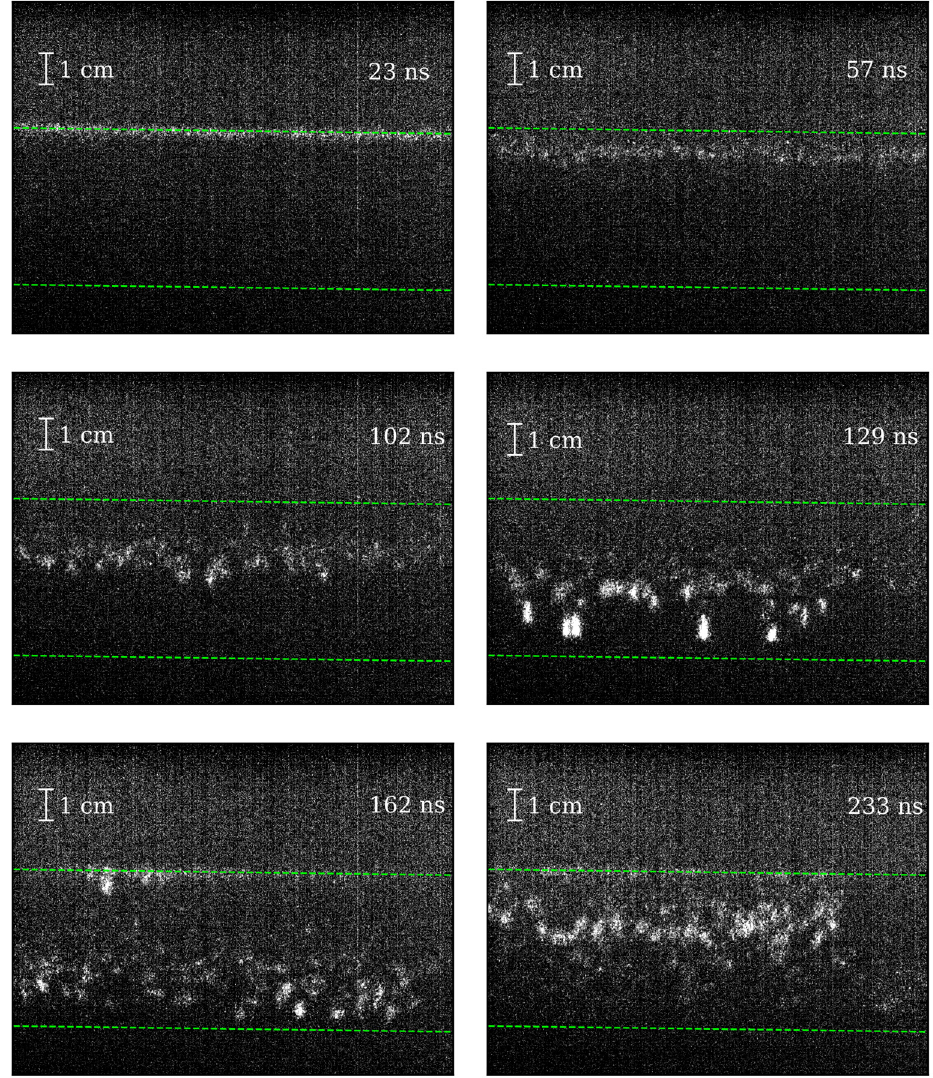
Figure 3. Photos of the streamer discharge taken at various delays relative to the front edge of the current pulse (shown in the margins of the photos). The green dashed line marks the positions of the anode (top) and cathode (bottom). The anode-to-ground potential difference is 35 kV.